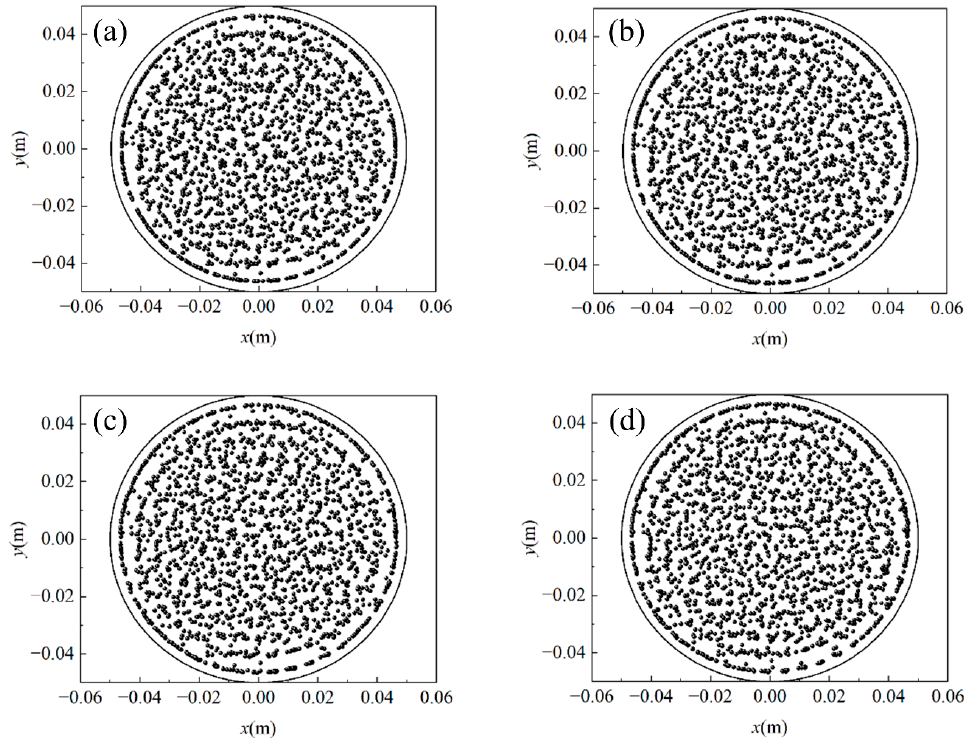
Figure 5. Particle center coordinates under different vertical pressures: ( a ) 0 kPa ( b ) 50 kPa ( c ) 150 kPa ( d ) 250 kPa.